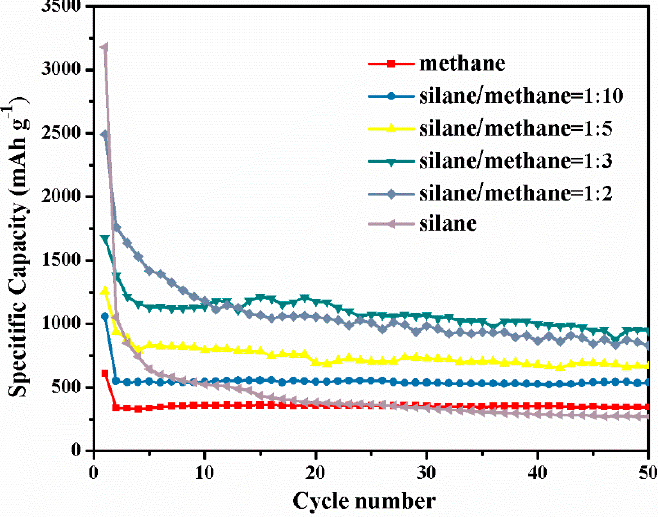
Figure 3. Cyclic performance of the silicon-carbon nanocomposite prepared under different silane/methane ratios at 150 mA g − 1 between 0.01 and 1.5